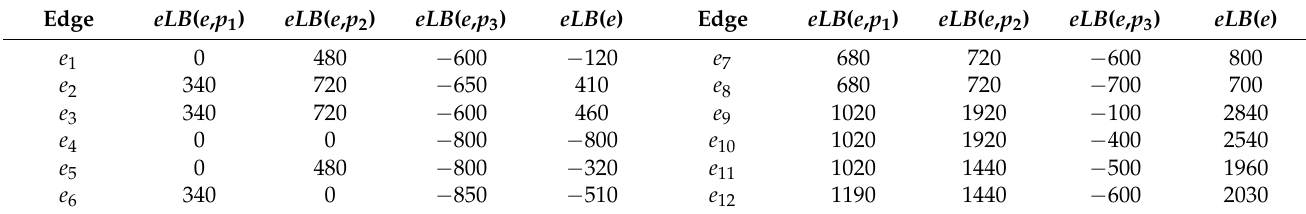
Table A14. Lower bound of the edges.